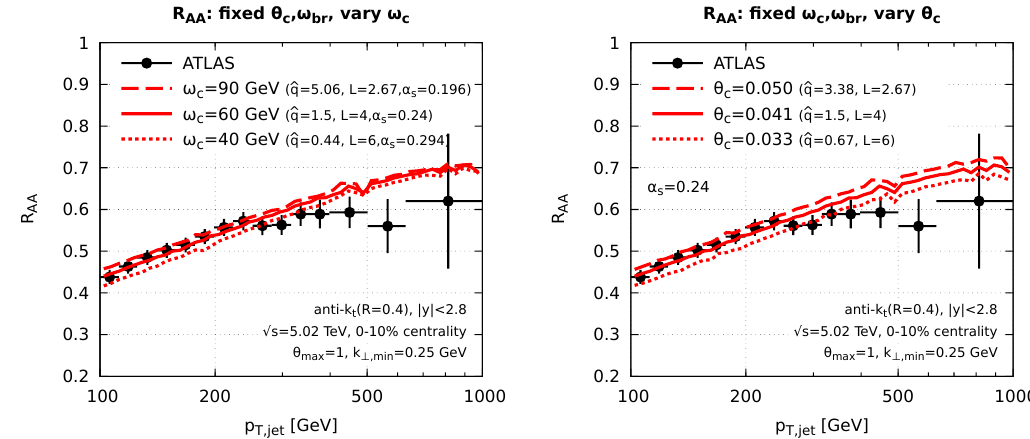
Figure 7 . The e(cid:11)ects of varying the medium parameters ^ q , L and (cid:11) s; med in such a way to keep a constant value for ! br (the same as the central value in the right plot in (cid:12)gure 6, i.e. ! br = 3 : 46 GeV). Left: we vary ! c by (cid:6) 50% at (cid:12)xed (cid:18) c . Right: we vary (cid:18) 2